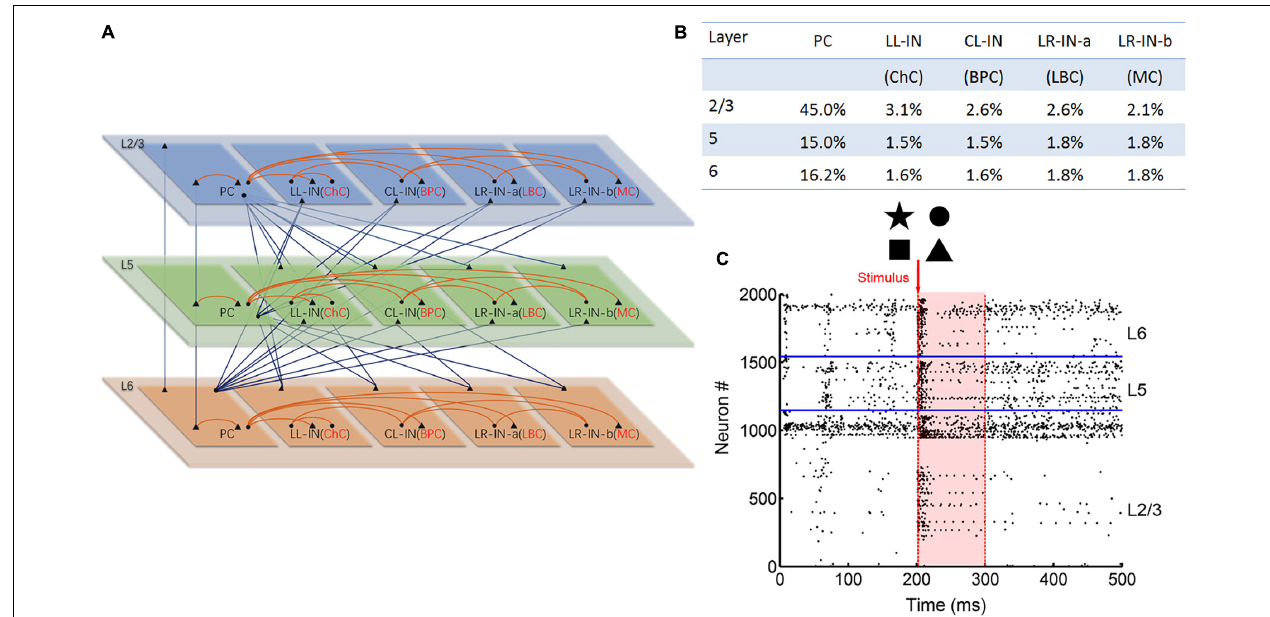
FIGURE 1 | Anatomical and stimulation diagram. (A) Laminar connection of a single column. Triangles indicate excitatory synaptic projection and dots indicate inhibitory synaptic projection. The red lines indicate local layer connections, and the blue lines indicate the cross-layer connections (PC, pyramid cell; LL-IN, local-layer connection interneuron; CL-IN, cross-layer connection interneuron; LR-IN, long-range connection interneuron; ChC, chandelier cell; BPC, bipolar cell; LBC, large basket cell; MC, Martinotti cell). (B) Parameters of different types of neurons are proportionally distributed across layers. (C) Network stimulation diagram. Red arrow shows that different pictures stimulate the L2/3 pyramidal cell. The shades of light red indicate the information